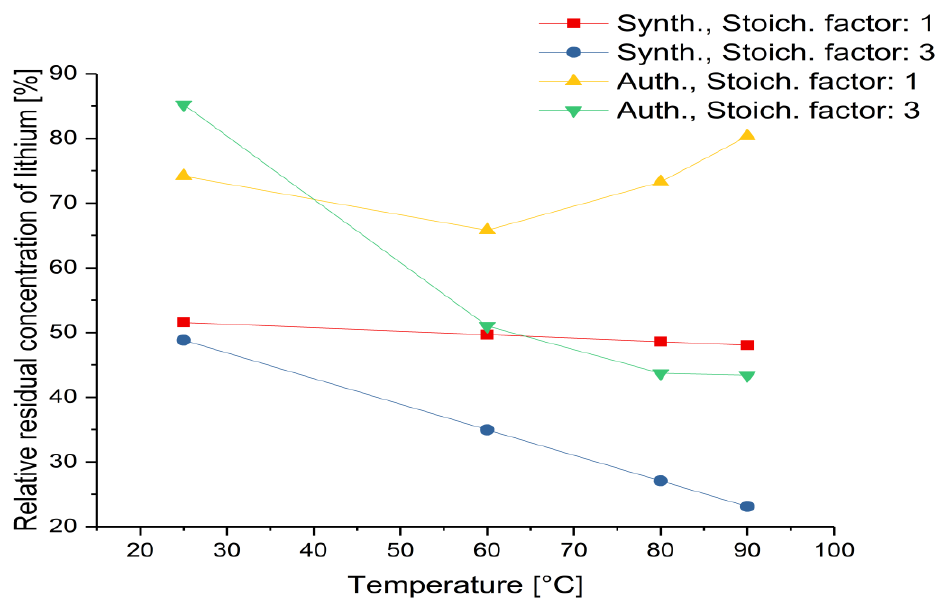
Figure 7. Relative residual concentration of lithium in the samples as a function of temperature and stoichiometric factor (interaction plot of the model) based on the authentic leaching solution for the precipitation with Na 2 CO 3 .